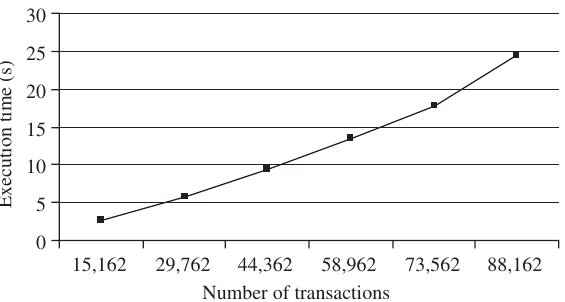
Figure 9. Execution time vs. size of database at minsupp = 0.25, mininterval = 8, maxgap = 10 ( retail ).